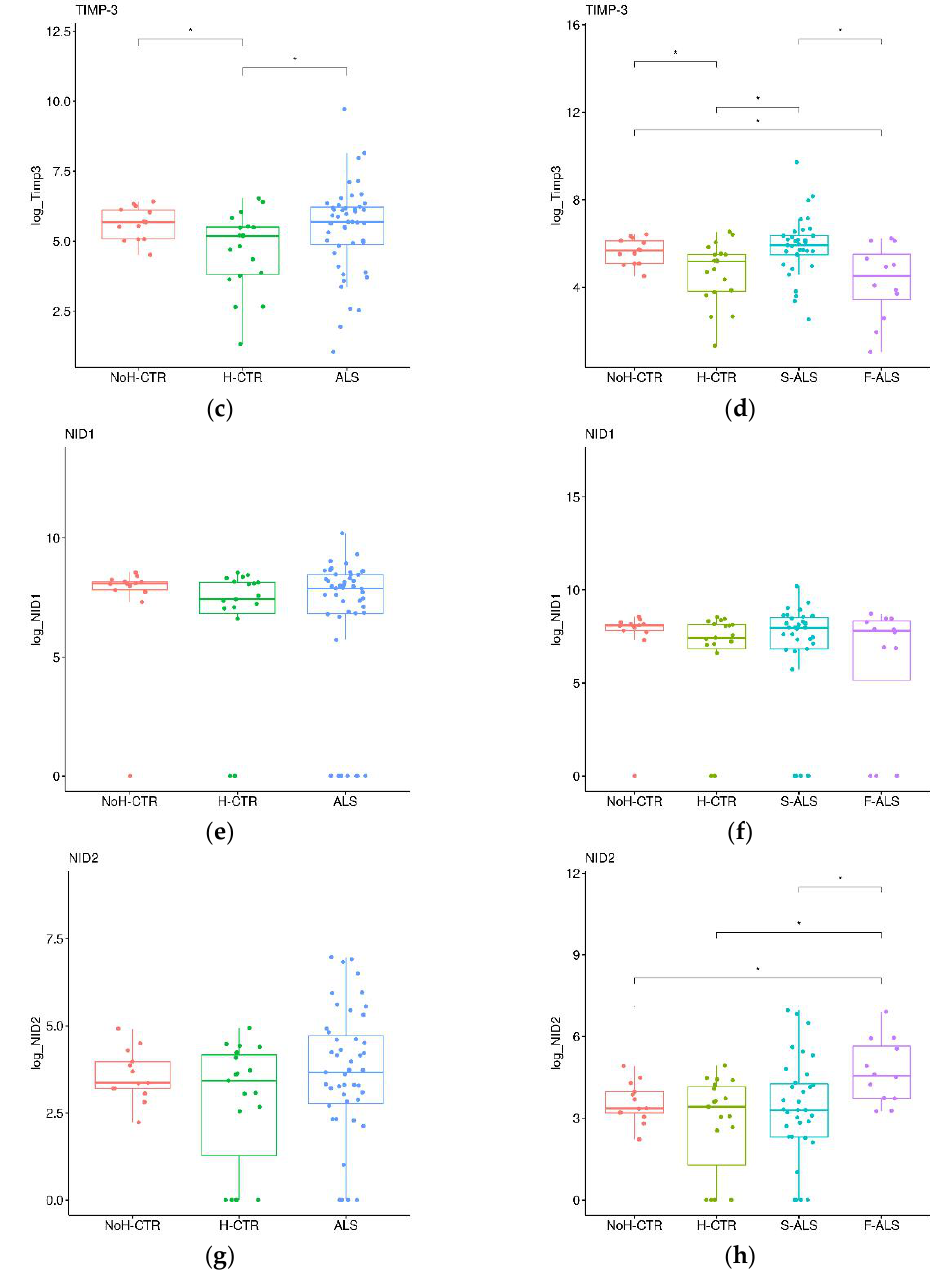
Figure 6. Box plots of individual plasma proteins levels in different diagnostic groups. The plasma TARC ( a , b ), TIMP-3 ( c , d ), NID1 ( e , f ) and NID2 ( g , h ) levels were measured in ALS patients (together on the left panels and divided into F-ALS and S-ALS in the right panels) and controls (H-CTR and NoH-CTR). * Post hoc p -value < 0.05.